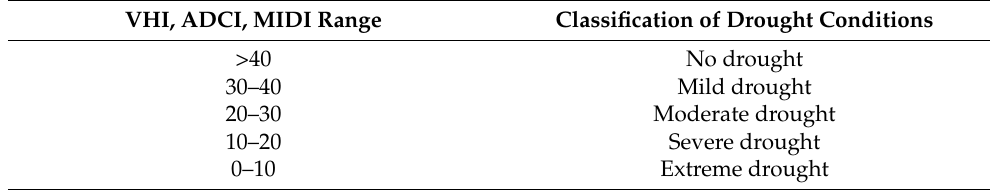
Table 3. Classification of drought conditions according to VHI, ADCI, and MIDI